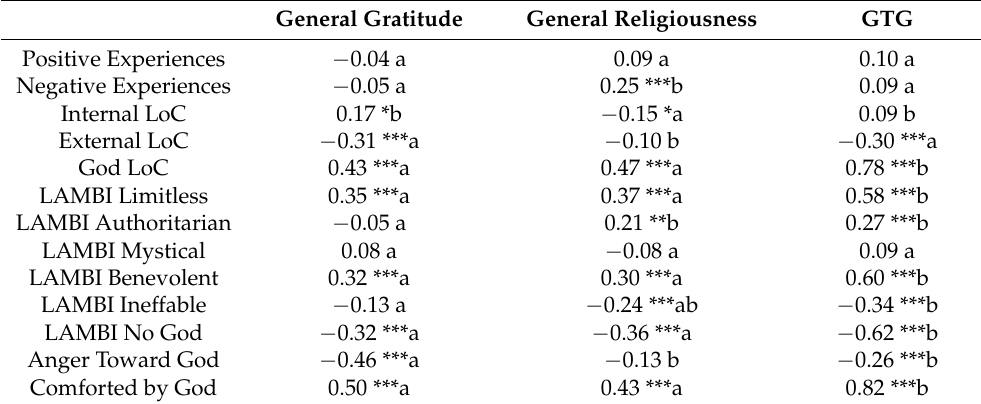
Table 5. Partial Correlations Examining whether GTG Shows Distinctive Patterns of Associations Compared to General Gratitude and Religiousness. General Gratitude General Religiousness GTG Positive Experiences − 0.04